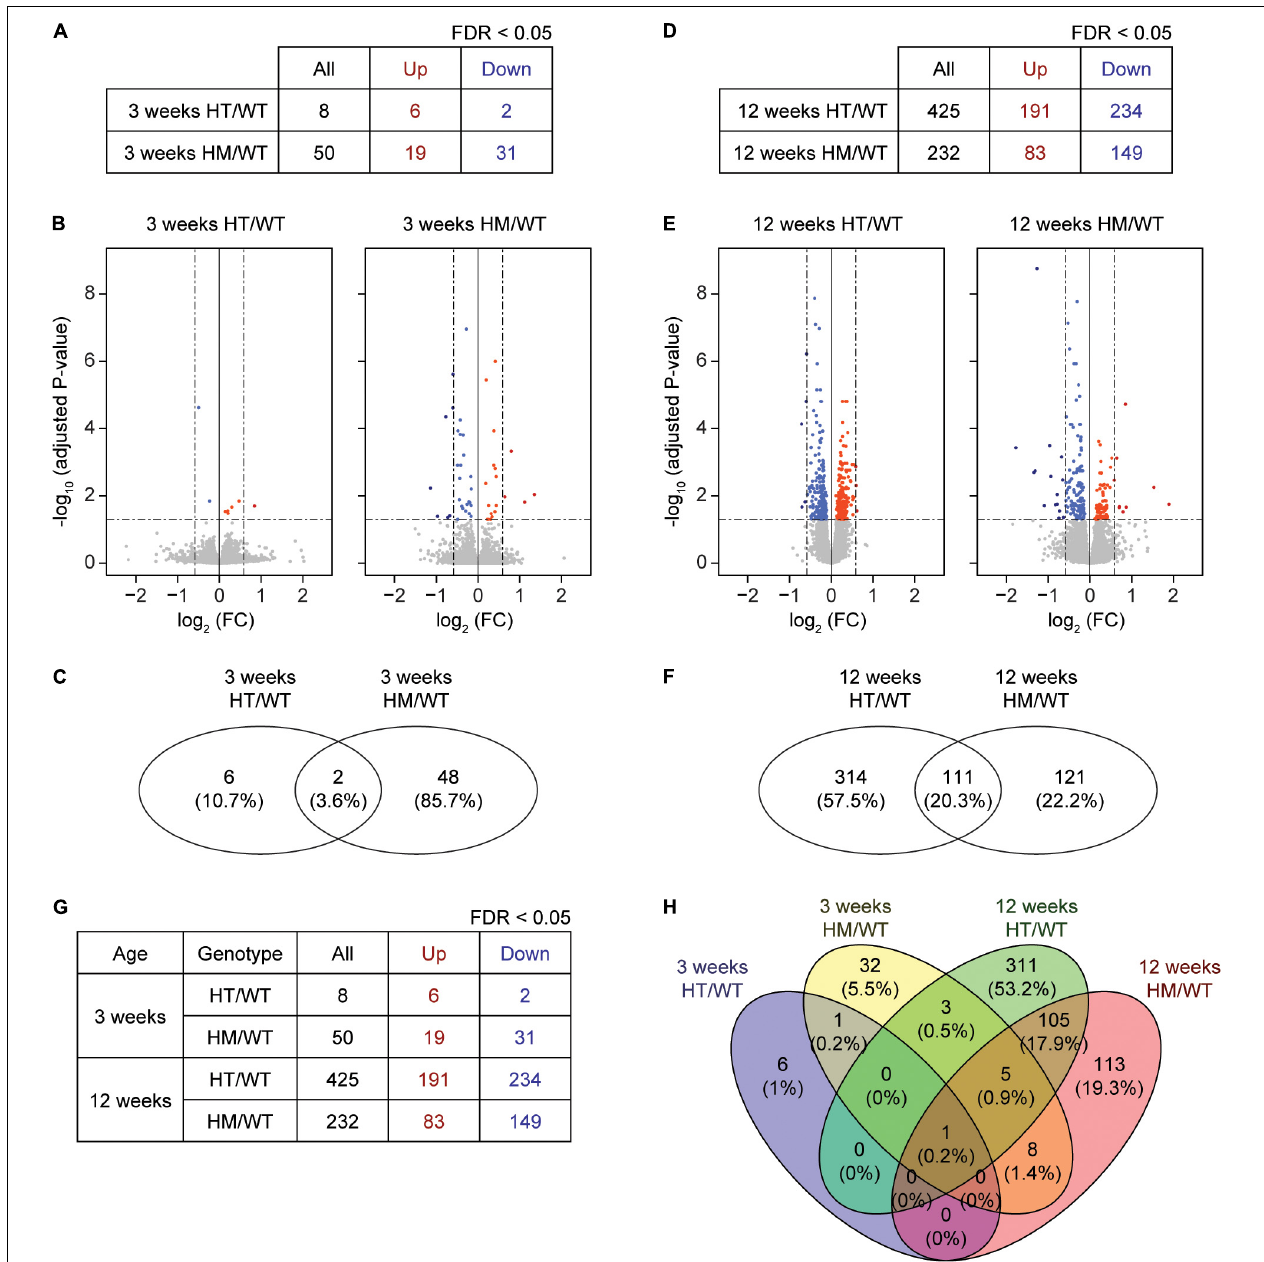
FIGURE 1 | DEG analyses based on RNA-Seq results from W3-HT, W3-HM, W12-HT, and W12-HM Shank2 -mutant mice. (A–C) Summary table, volcano plot, and Venn diagram for DEGs from the prefrontal cortex of W3-HT and W3-HM Shank2 -mutant mice, relative to WT mice. Red, upregulation; blue, downregulation ( n = 5 mice for W3-WT/HT/HM; dotted lines indicate adjusted p value < 0.05, |FC| > 1.5, of which only adjusted p values but not FCs were used to define DEGs). (D–F) Summary table, volcano plot, and Venn diagram for the DEGs from the prefrontal cortex of W12-HT and W12-HM Shank2 -mutant mice, relative to WT mice. Red, upregulation; blue, downregulation ( n = 4 mice for W12-WT/HT/HM; dotted lines indicate adjusted p -value < 0.05, |FC| > 1.5). (G,H) Table summarizing all DEGs and a Venn diagram showing the overlaps in DEGs from W3-HT, W3-HM, W12-HT, and W12-HM Shank2 -mutant mice. Red, upregulation; blue, downregulation.